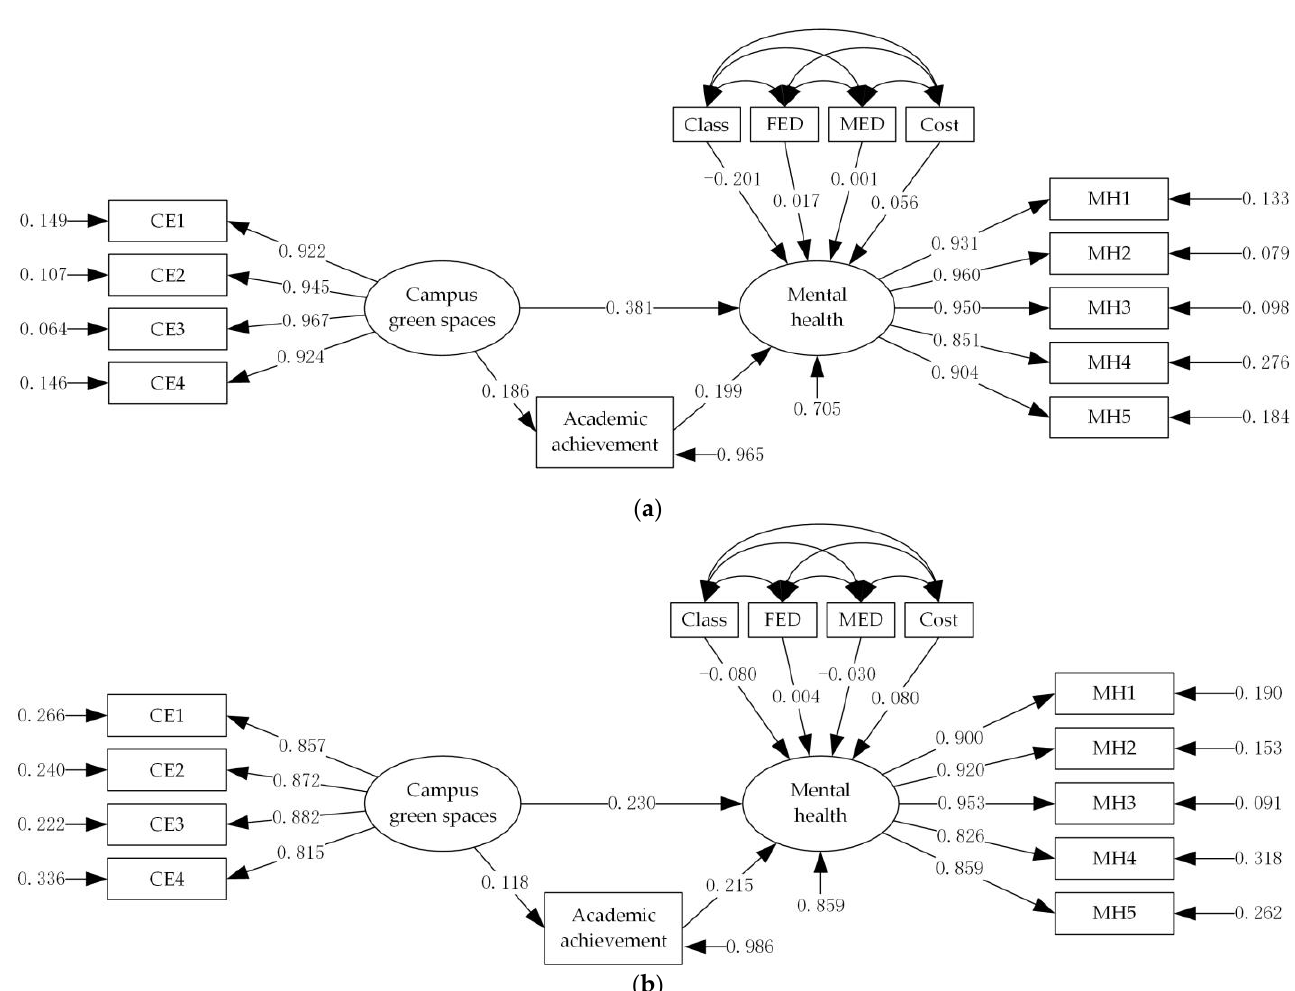
Figure 2. Comparison of standardized path diagram for different gender groups. ( a ) Male group. ( b ) Female group.